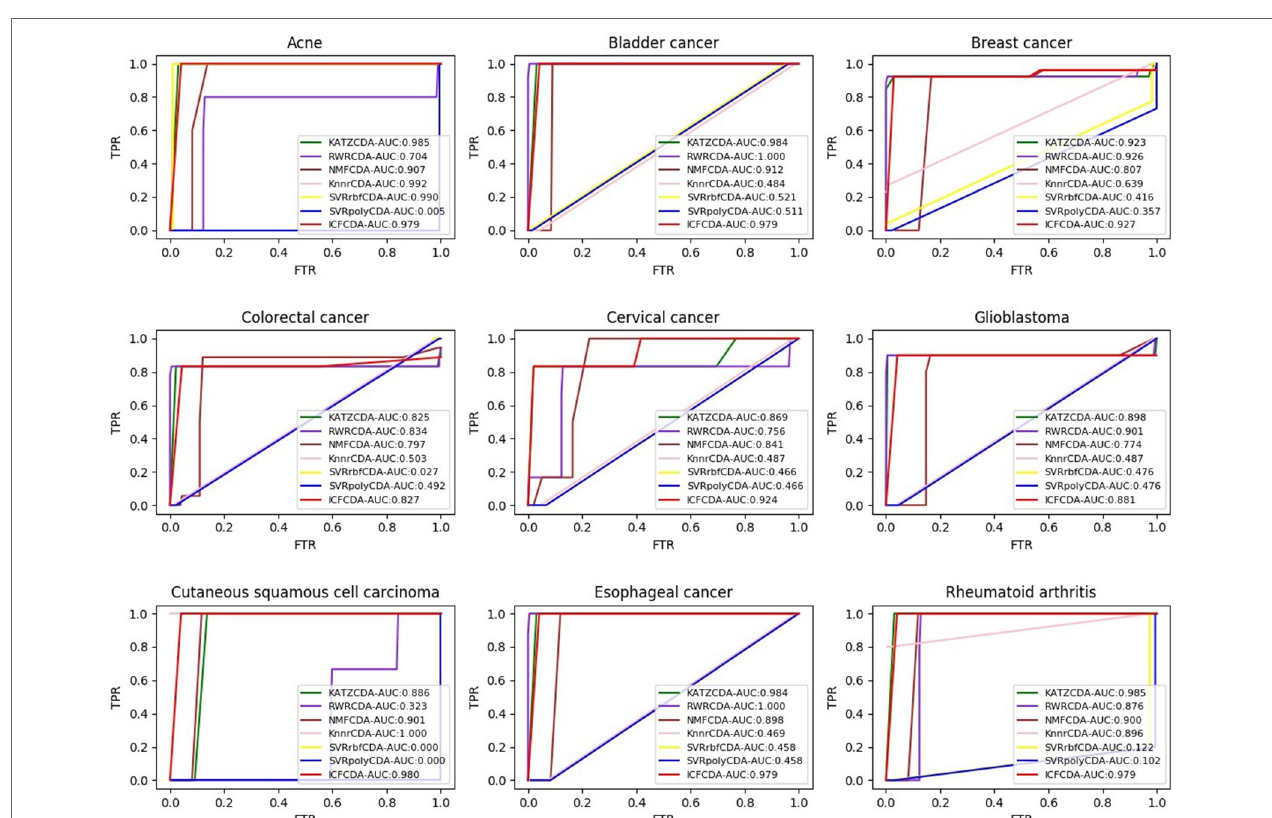
FIGURE 4 | The AUC values of nine kinds of specific diseases.